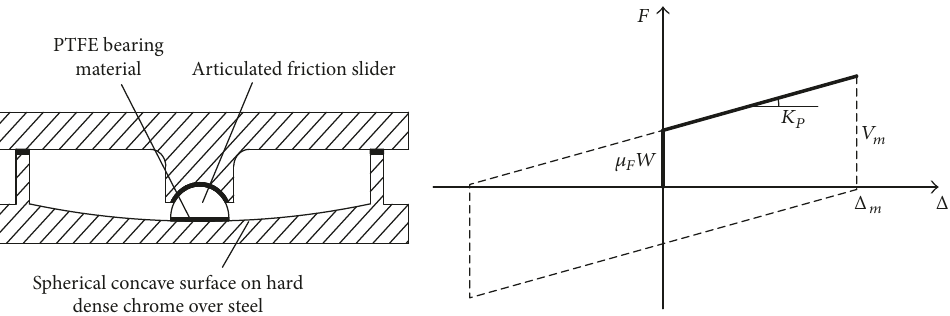
Figure 8: Scheme and hysteresis loop of a FPD